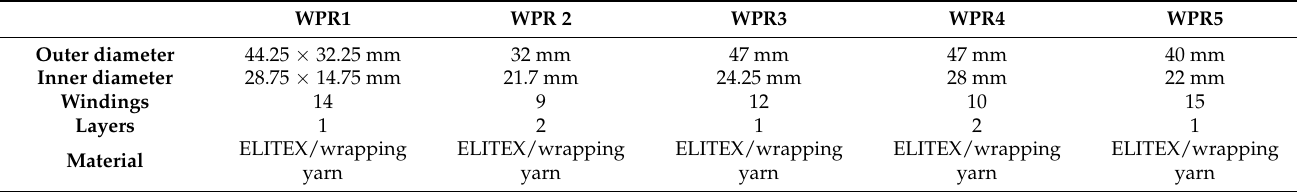
Table 4. Structure of the wound coils according to Qi